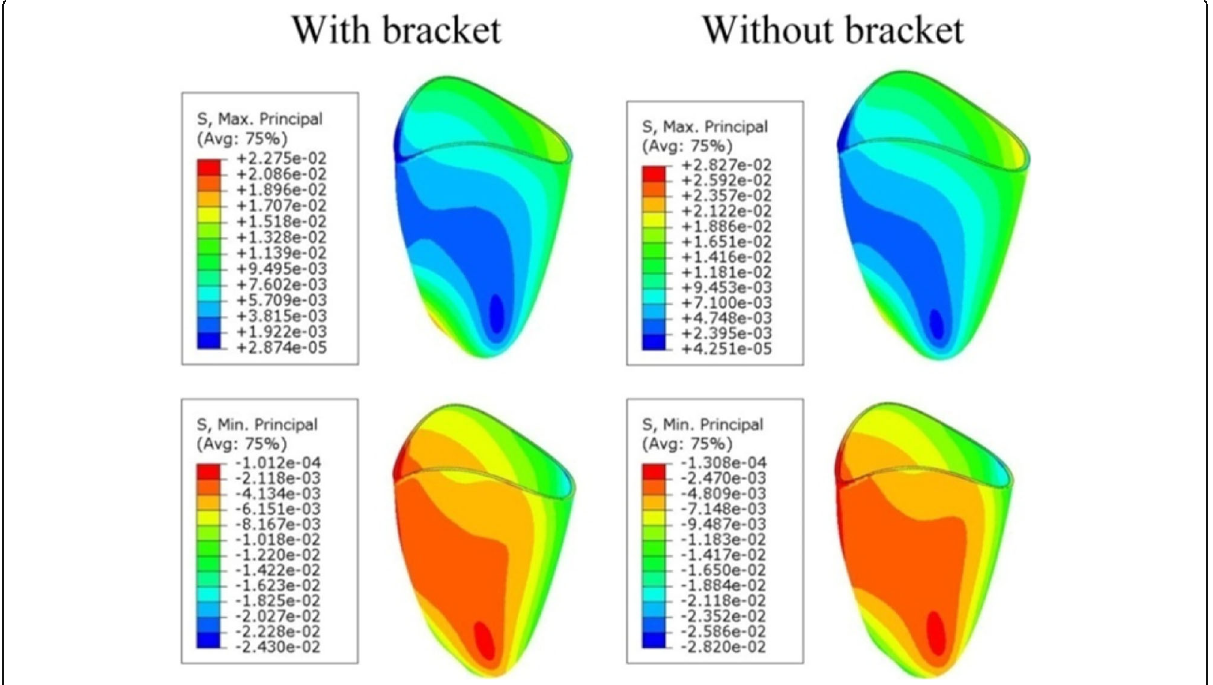
Fig. 7 The nephogram of maximum and minimum principal stresses distribution for the PDL (M/F =